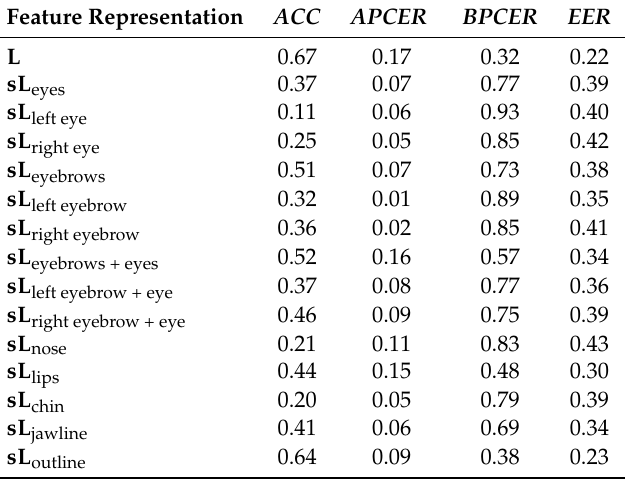
Table 3. Results for the ablation